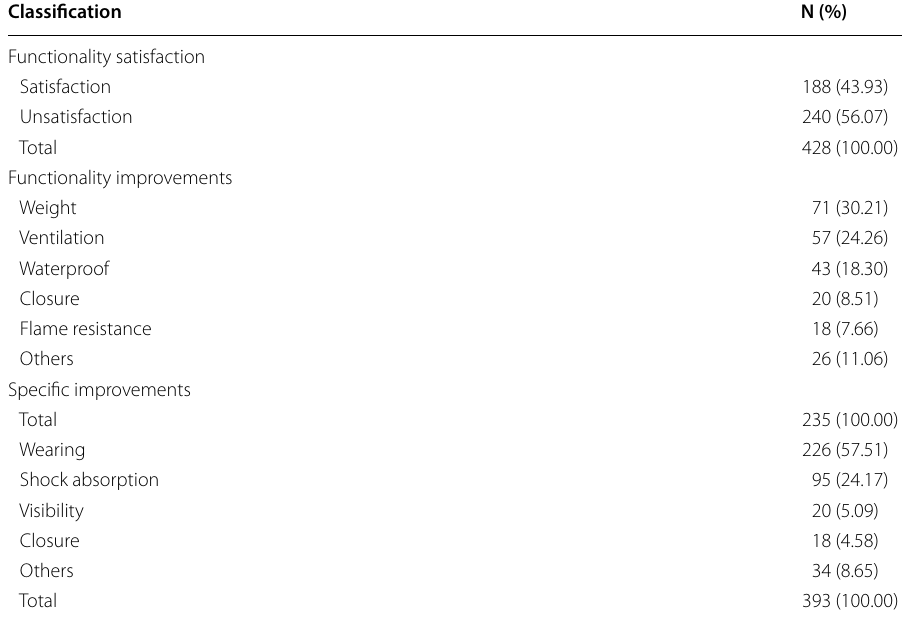
Table 2 Functionality evaluation of protective footwear for firefighters in Korea Classification